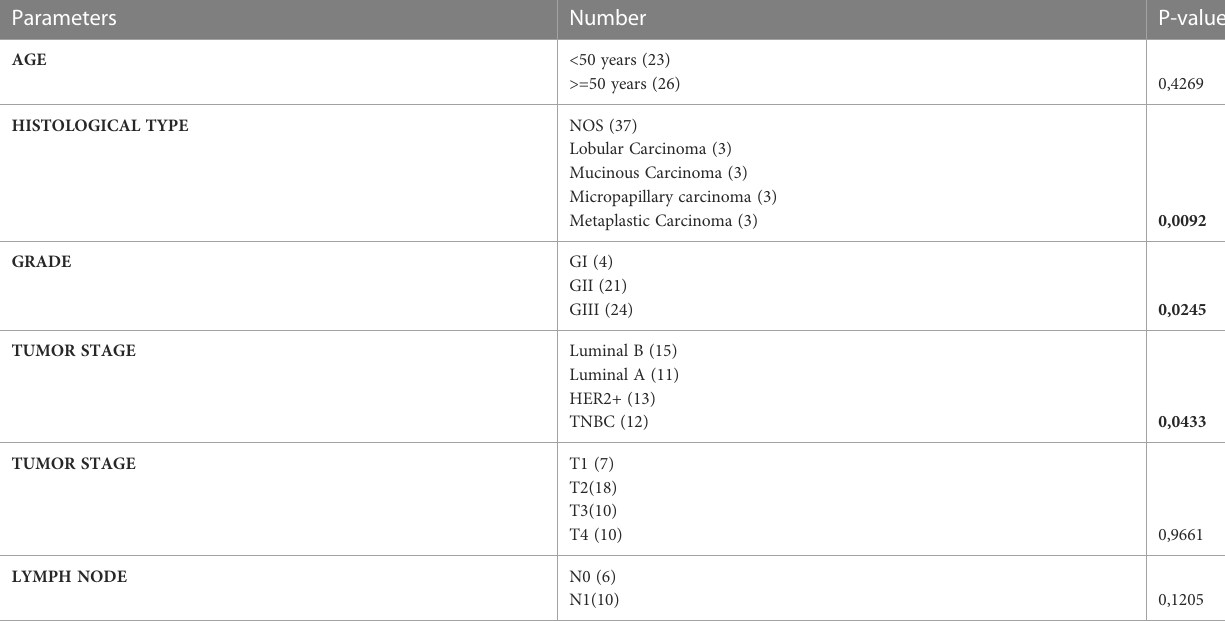
TABLE 2 VISTA expression on immune cells in breast cancer patients and their clinical